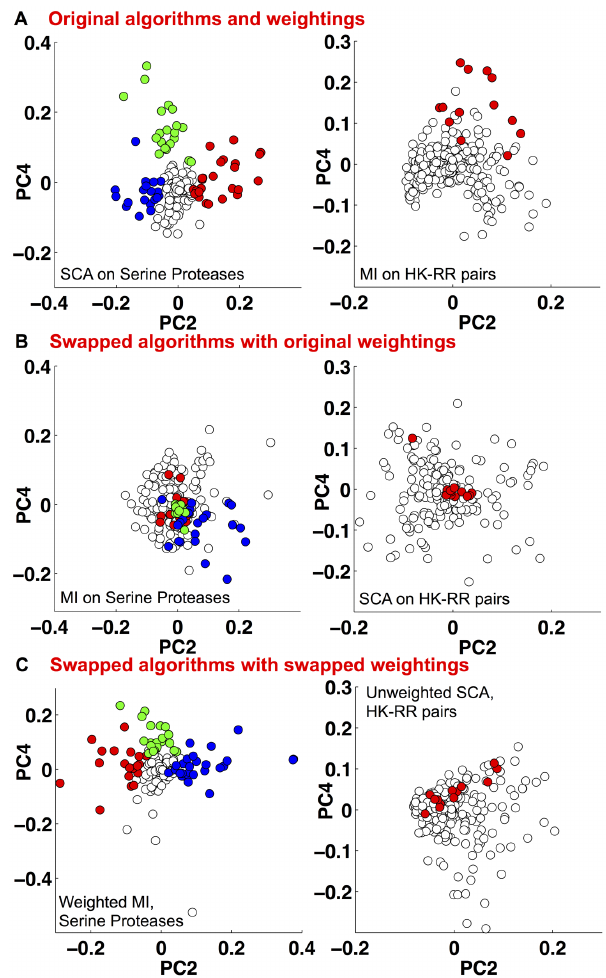
Figure 1. A) PCA of (left) the correlation matrix produced by SCA v3.0 applied to the serine protease alignment and (right) the correlation matrix produced by MI applied to the histidine kinase - response regulator (HK-RR) alignment (see methods). These plots largely recover the experimentally verified residues (red, green and blue) that control the different phenotypes identified in [8] and [7] respectively. B) (Left) Applying MI to the serine protease alignment does not recover the functionally relevant residues, colored as (A), they mostly cluster around the origin. (Right) Applying SCA to the HK-RR sequence alignment also does not recover the relevant residues. C) (Left) Applying MI combined with the SCA weighting function to the serine protease alignment recovers the relevant residues, compare with A. (Right) Application of unweighted-SCA to the HK-RR alignment improves performance at detecting the relevant residues.